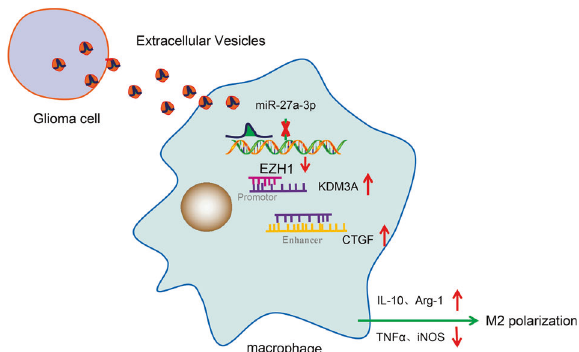
Fig. 8 Schematized molecular mechanism underlying hsa-miR- 27a-3p contained in GBM-EVs. EV hsa-miR-27a-3p inhibits the mRNA expression of target gene EZH1 to upregulate KDM3A - mediated CTGF mRNA expression, which induces M2 macrophage polarization and further facilitates proliferation, migration and invasion of GBM